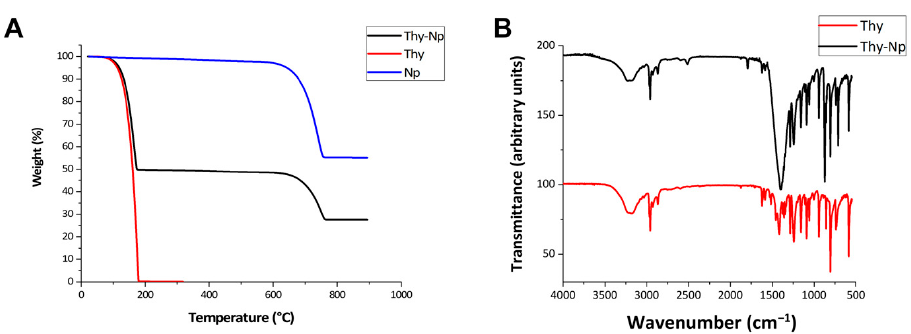
Figure 2. ( A ) TGA thermograms of thymol-loaded CaCO 3 nanoparticles (black trace) of the as- prepared CaCO 3 nanoparticles (blue trace) and of pure thymol (red trace); ( B ) FT-IR